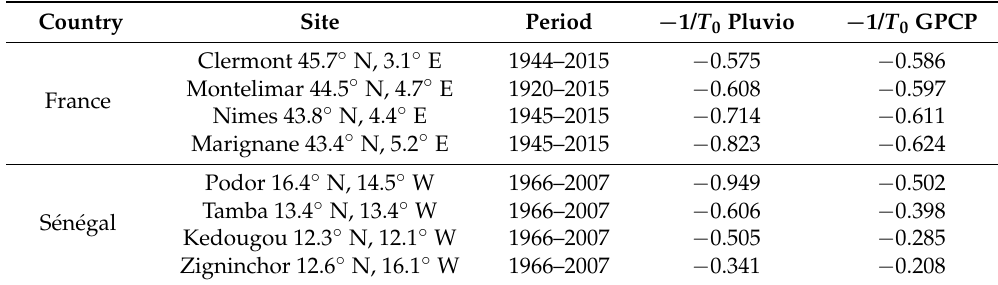
Table 1. Slope values ( − 1/ T 0 ) obtained with an exponential distribution of the duration of rainy events for the sites in France and Senegal. The slopes estimated from rain gauge data on the sites and GPCP data on the nearest pixels of the